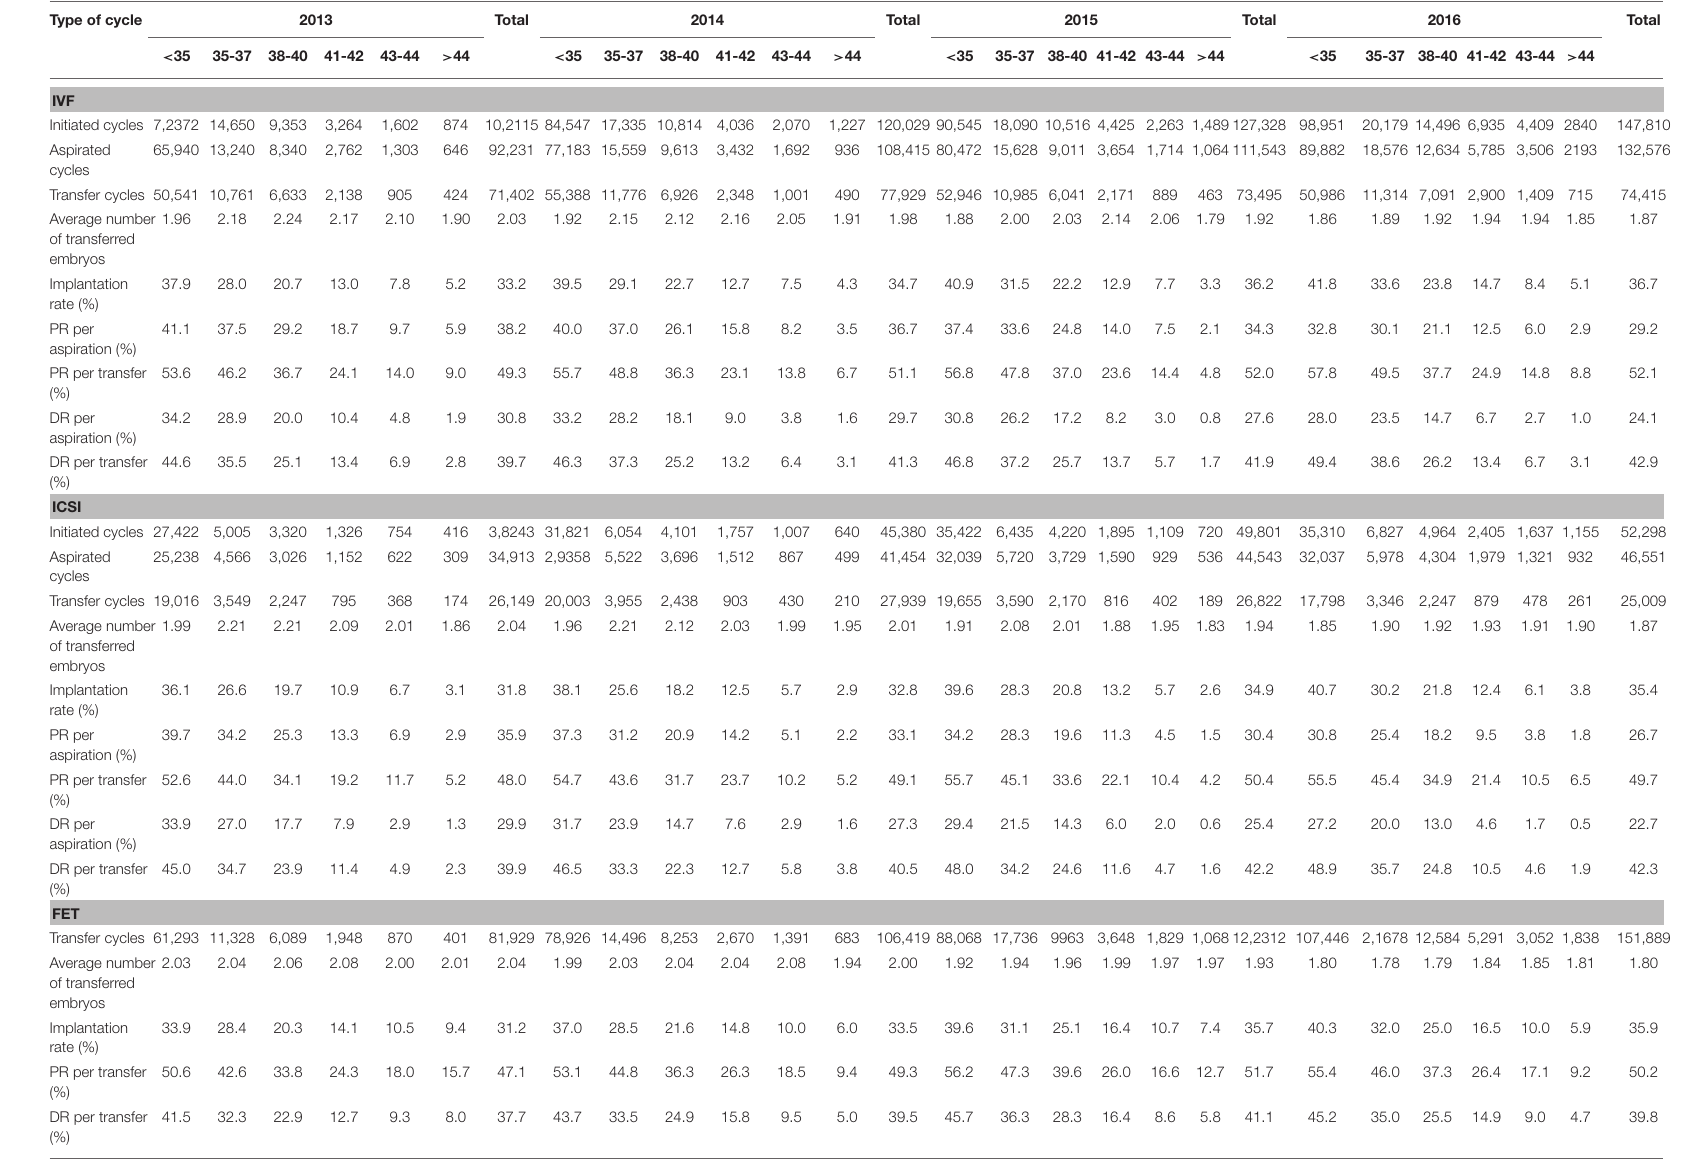
TABLE 2 | Results after fresh and frozen non-donor cycles in